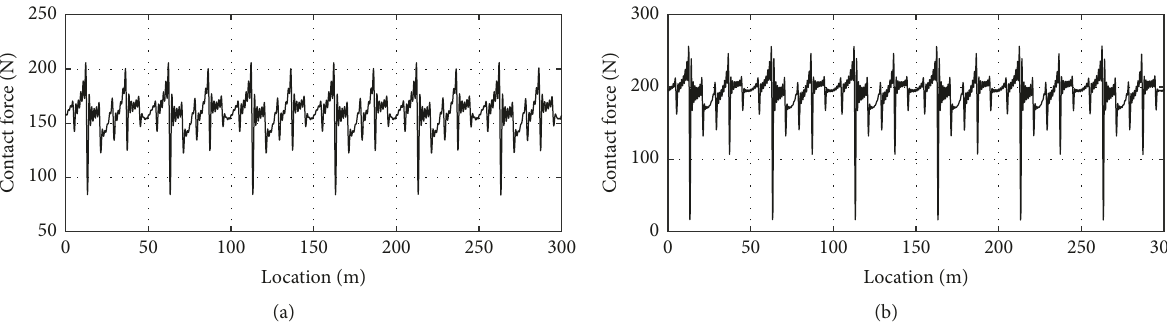
Figure 17: The variation of contact forces for the elastic stitched catenary when (a) 𝑉 = 300 km/h and (b) 𝑉 = 350 km/h. ×10 −4